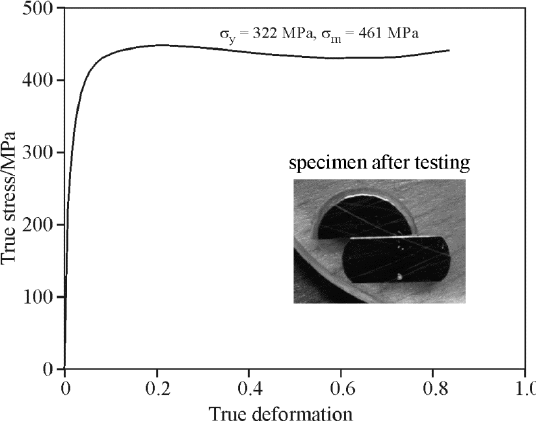
Figure 9. The compression test of the alloy Al 95.4 Mn 1.8 Cu 1.6 Be 1.2 after ageing at 400 °C for 1 h, 6 mm sample. The specimen after testing is shown.